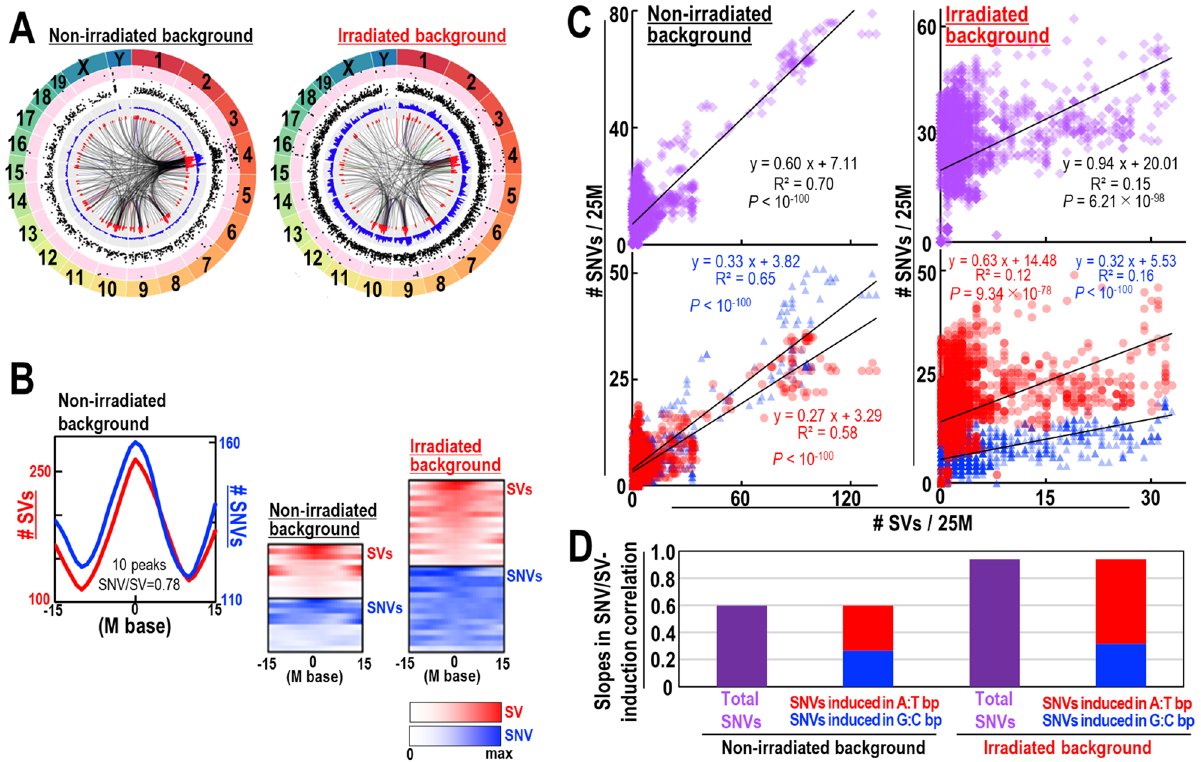
Figure 6. SV-associated SNV induction and association with clonal evolution. ( A ) Genome-wide Circos plots of SVs and SNVs from immortalized MEFs with and without exposure to gamma-ray irradiation (1 Gy). Chromosome ideograms are shown around the outer ring. Two inner circular tracks show numbers of SVs (red) and SNVs (blue) with corresponding moving averages. Inner lines: blue, duplications; green, inversions; red, deletions; black, translocations. SNVs are also shown as rainfall plots, with the black dots within pink and white circular zones indicating inter-SNV distances of < 1 kb and 1 kb–1 Mb, respectively. ( B ) SV peaks (red) and associated SNV statuses (blue) are superimposed and shown with peaks ± 15 Mb (top: non-irradiated) with alignment densities (bottom: 1 Gy-irradiated and non-irradiated). ( C , D ) Associations of SVs and